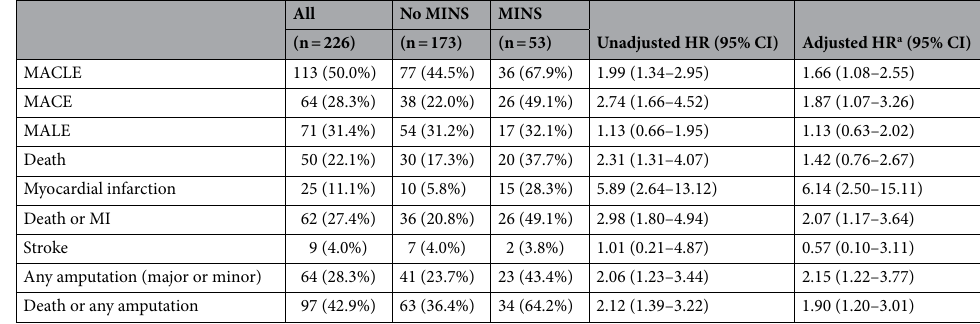
Table 4. Clinical outcomes over long-term follow up after lower extremity revascularization. MACE major adverse cardiovascular events, MALE major adverse limb events, MACLE major adverse cardiovascular and limb events. a Cox proportional hazard models adjusted for age, sex, race/ethnicity, coronary artery disease, heart failure, baseline serum creatinine, and the surgical approach to